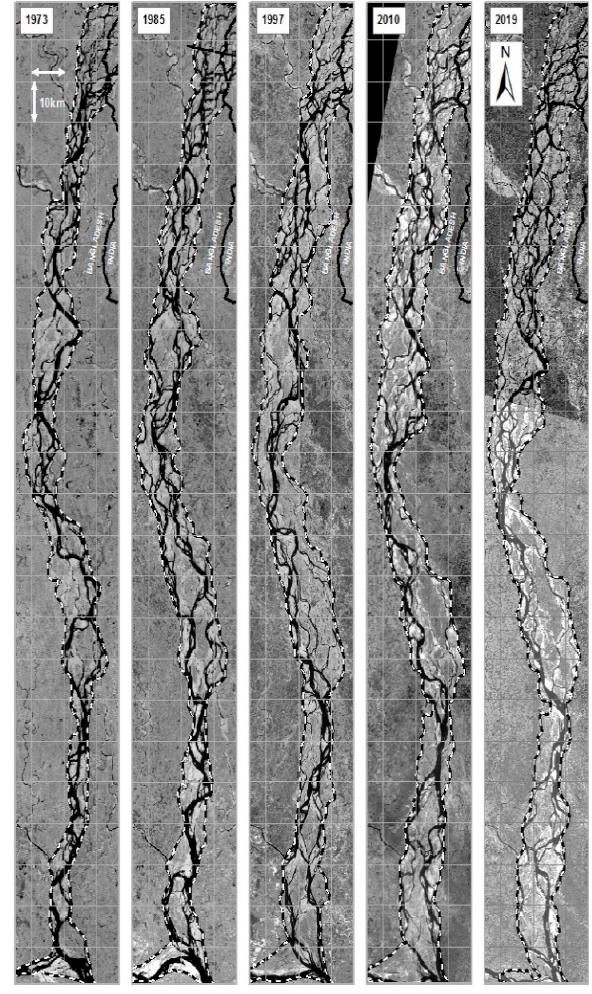
Figure 3. Dry season imagery of the Jamuna River over nearly half a decade (dashed lines show the flood plain boundaries) (source: CEGIS).